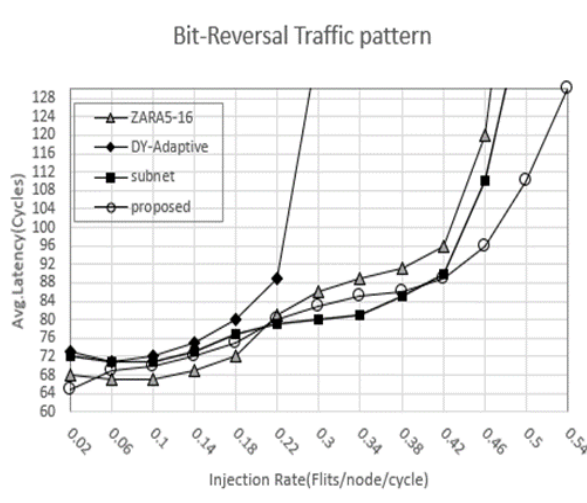
Fig. 11. Average latency evaluation under synthetic Transpose traffic pattern